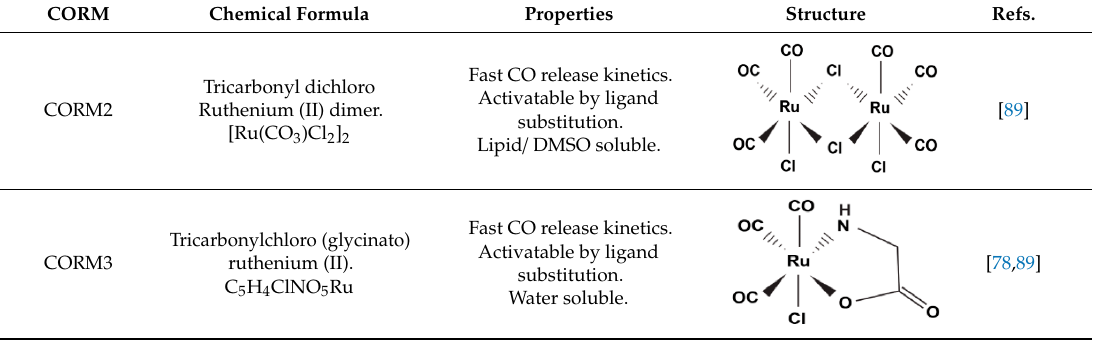
Table 1. Representative CORM compounds.